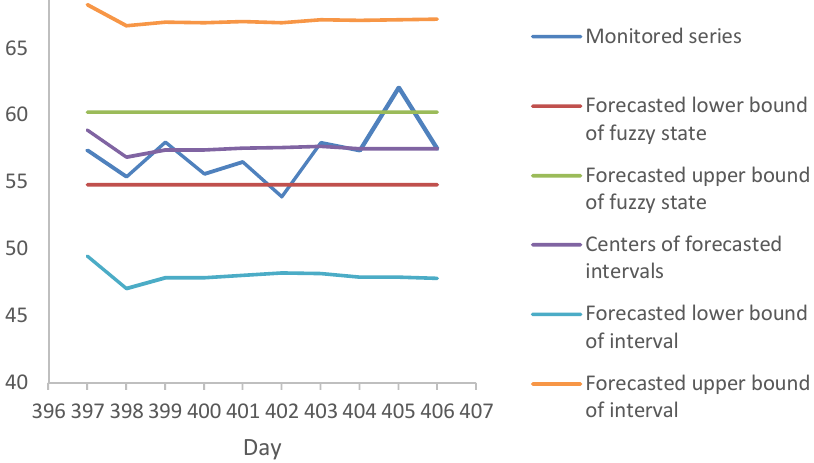
Figure 10. Plot of interval-valued autoregressive model, AR(5).